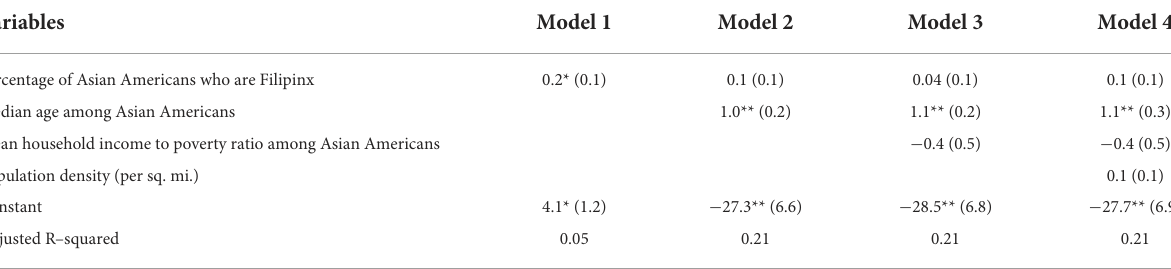
TABLE 1 Summary statistics for U.S. Counties that reported COVID-19 deaths among Asian Americans. County-level variable